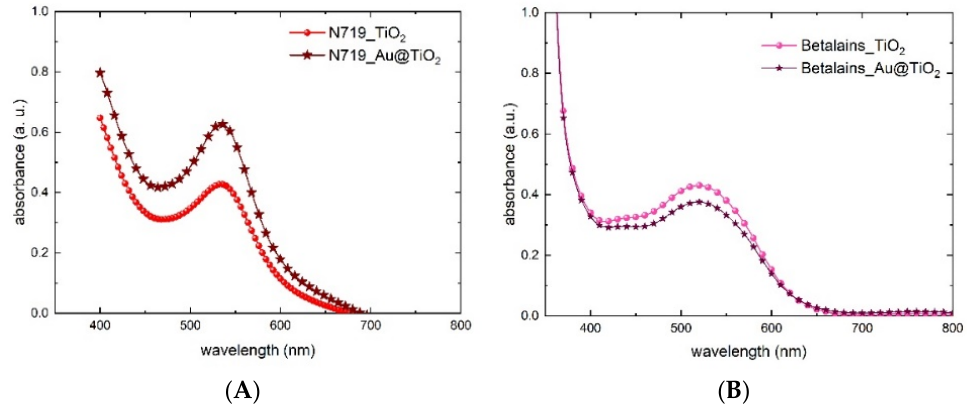
Figure 6. Absorbance spectra of the WE with the reference TiO 2 and the one mixed with Au@TiO 2 after dipping in ( A ) N719 and ( B )